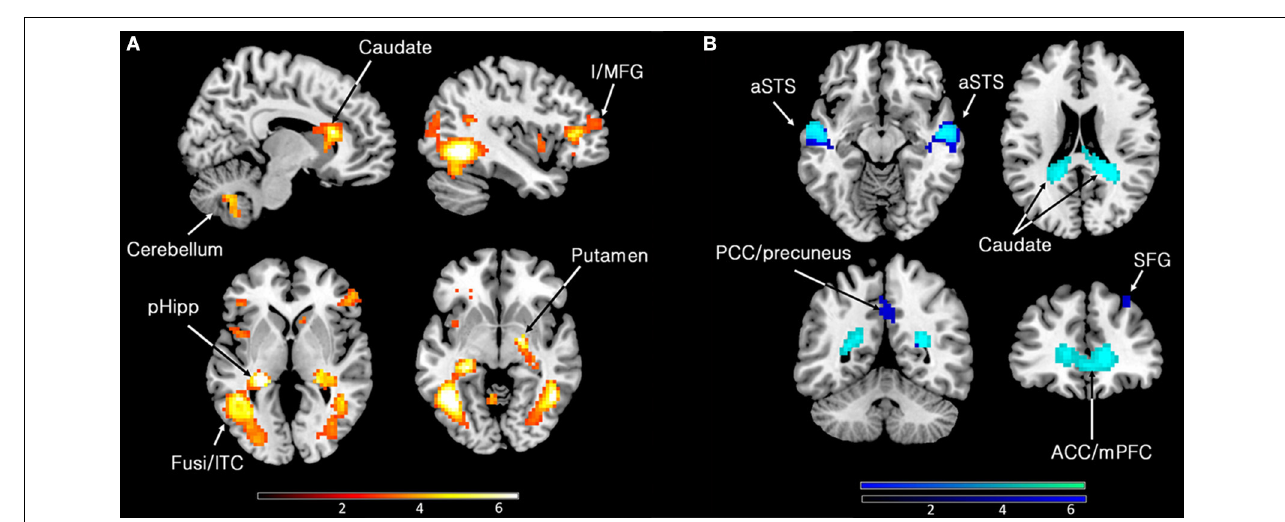
FIGURE 2 | (A) Parametric activations with sublimity. Statistical parametric maps rendered onto canonical anatomical sections showing t -statistics. Random effects analysis with 21 participants. Display threshold at p < 0 . 001 (uncorrected). I/MFG, inferior/middle frontal gyrus ( − 39 35 10); pHipp, posterior hippocampus ( − 24 − 31 1); Fusi/ITC, fusiform gyrus/inferior temporal cortex (48 − 55 − 8, − 45 − 58 − 5); caudate (head) (9 23 16); cerebellum (9 − 64 − 44). (B) Sites deactivated during the experience of sublimity relative to baseline activity. Display threshold at